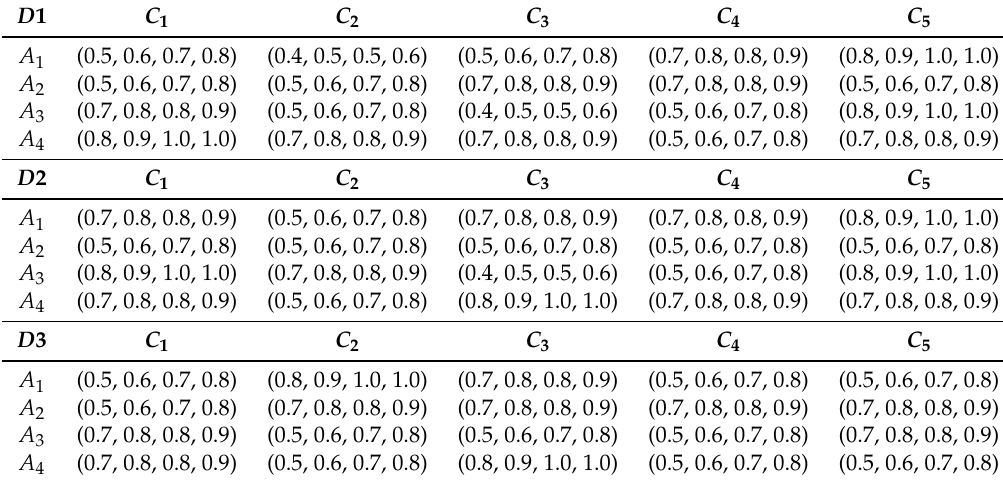
Table 1. A set of fuzzy ratings ˜ X k .